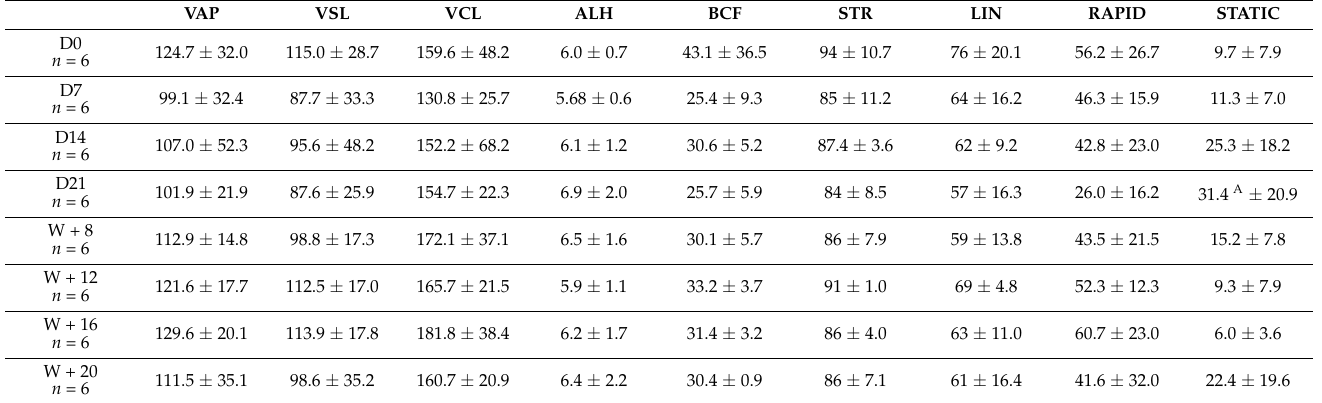
Table 6. Characteristic of sperm motility in semen fraction II samples collected from dogs in Group IV (BPH treated with Osaterone Acetate—YPOZANE ® VIRBAC ® )- comparison in relation to the study on day 0 ( n = 6). Results presented as mean ± SD ( A p <